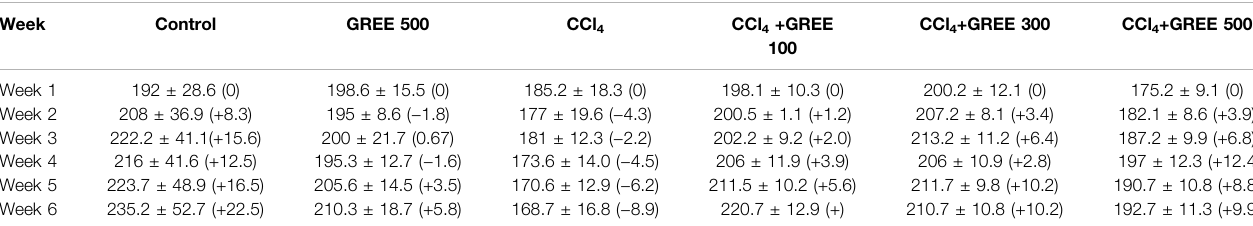
TABLE 4 | Effect of GREE on the body weight of animals.